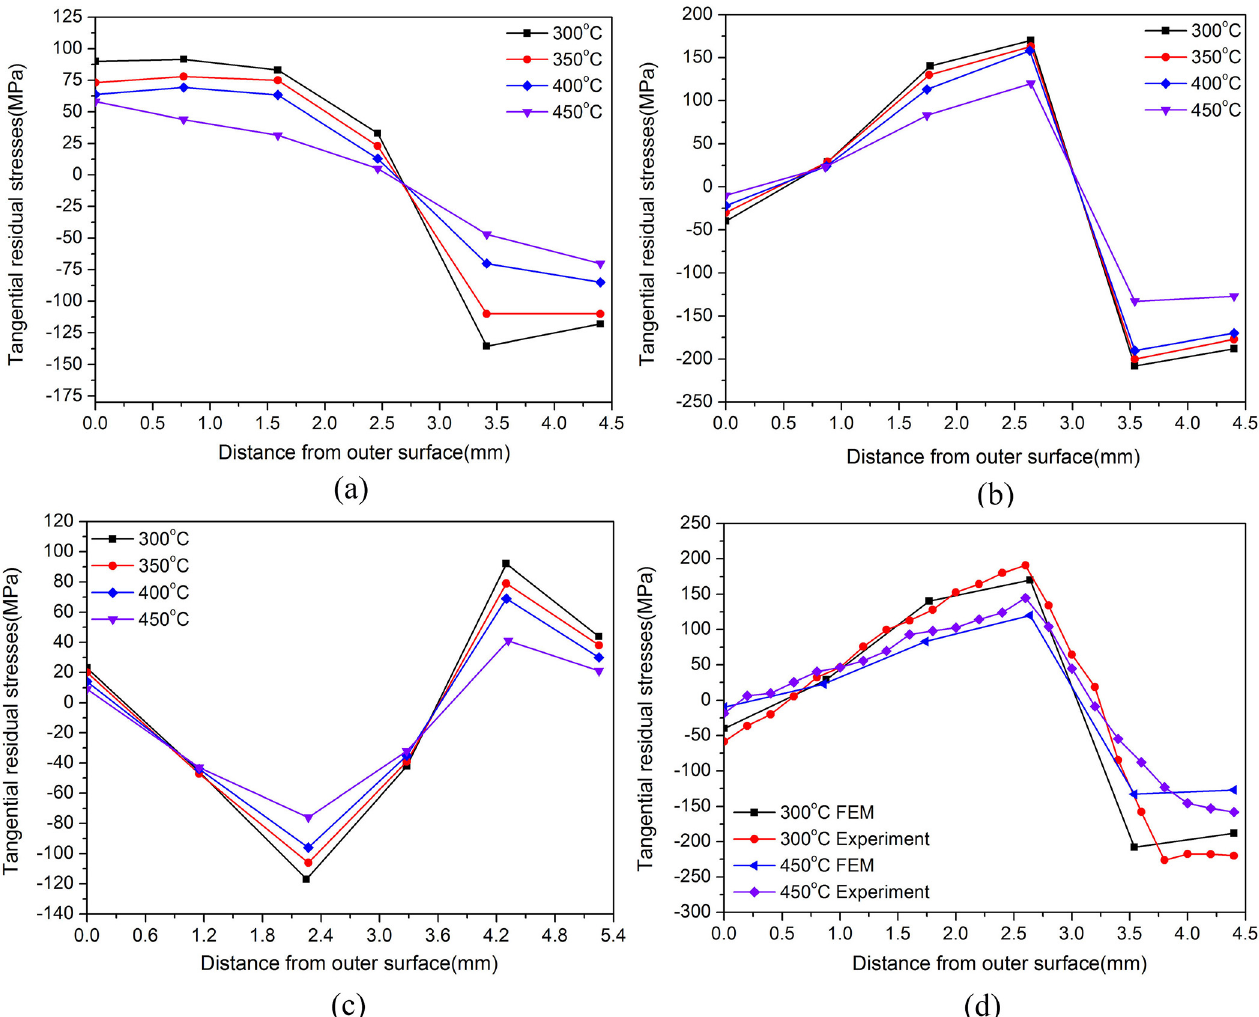
Fig. 7. Tangential residual stress distribution in the (a) cup bottom, (b) cup wall and (c) die entrance radius of square cups at various forming temperatures, and (d) comparison of the residual stresses in the cup wall obtained from numerical simulations and experimental